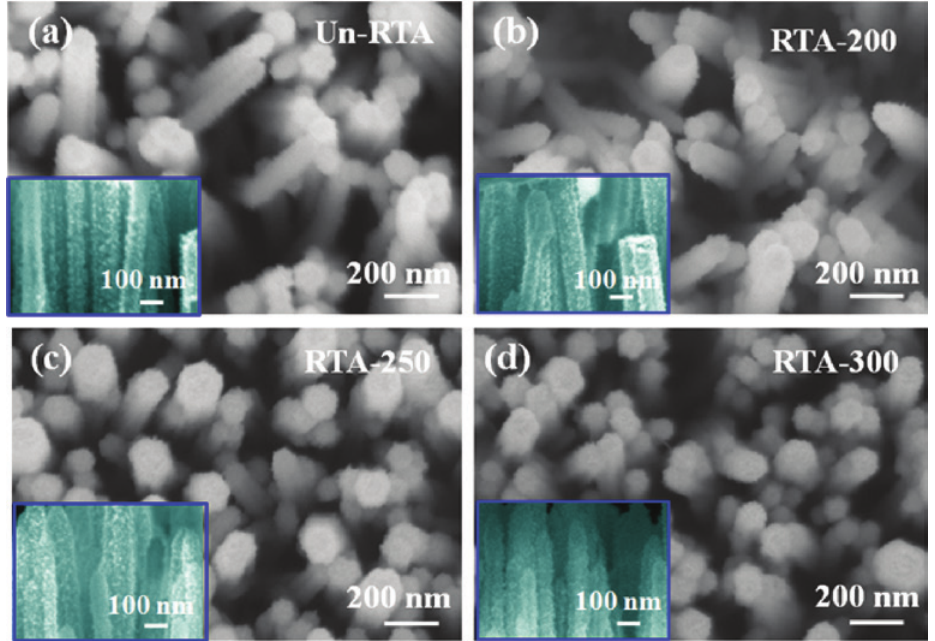
Figure 1: SEM images of ZnO/ZnS core-shell heterostructured NWs, the annealed 200 ° C (RTA-200), the annealed 250 ° C (RTA-250), and the annealed 300 ° C (RTA-300) NW samples. Insets show the individual NWs of samples’ SEM images.